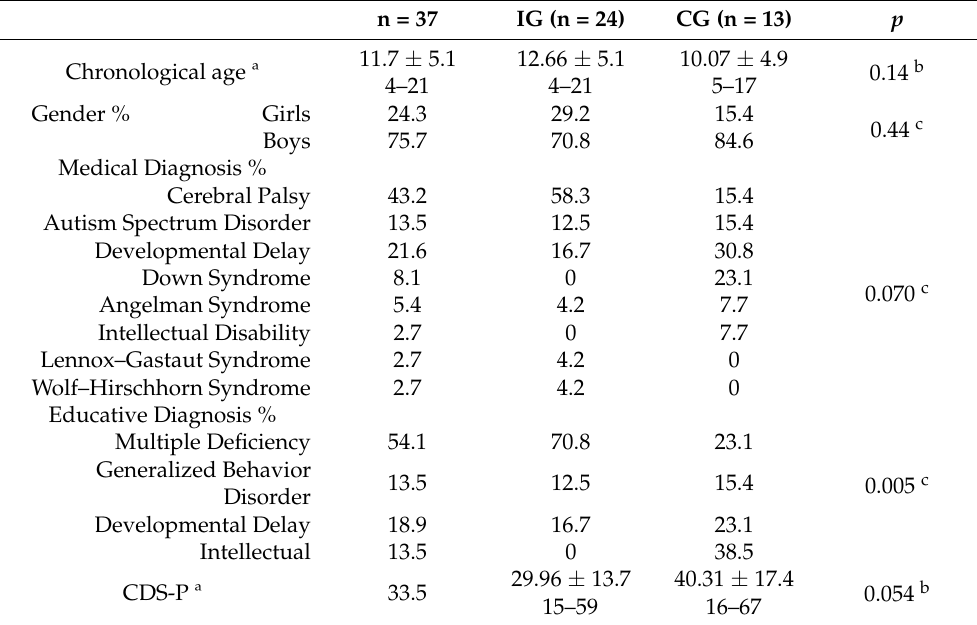
ª mean ± standard deviation. Minimum-Maximum b Independent t -test; c Chi-square test. Note: IG = intervention Group. CG= Control Group.